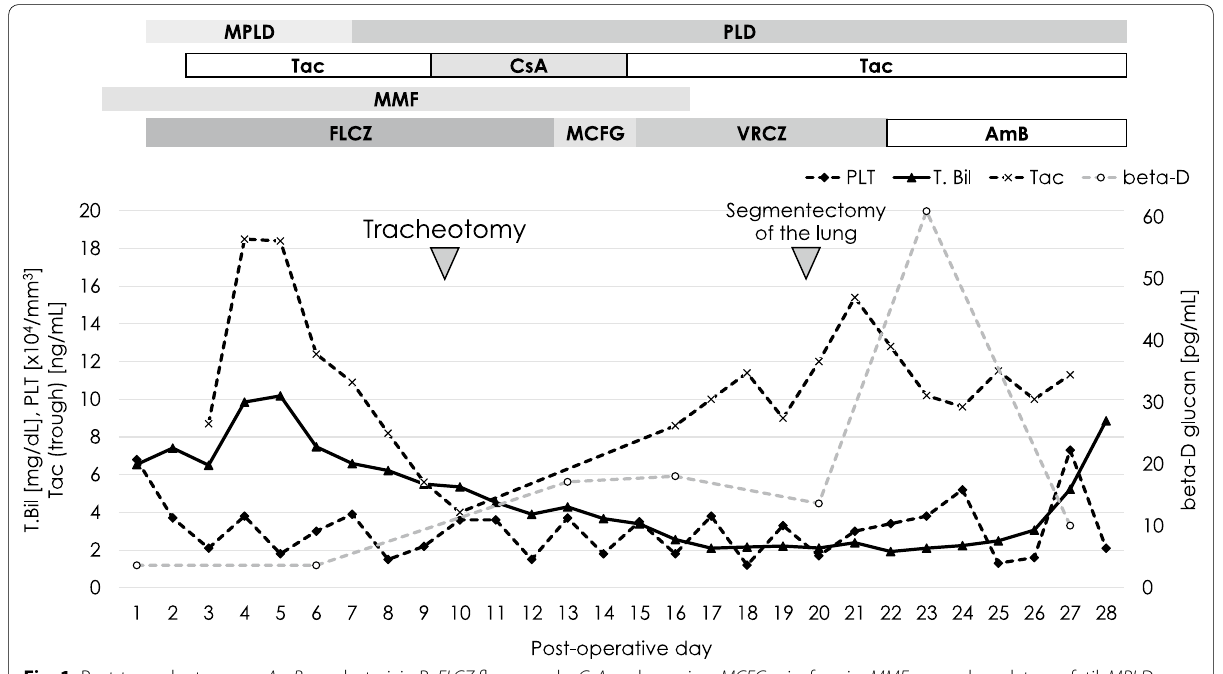
Fig. 1 Post-transplant course. AmB amphotericin B, FLCZ fluconazole, CsA cyclosporine, MCFG micafungin, MMF mycophenolate mofetil, MPLD methylprednisolone, PLD prednisolone, PLT platelet, Tac tacrolimus, T. Bil total bilirubin, VRCZ